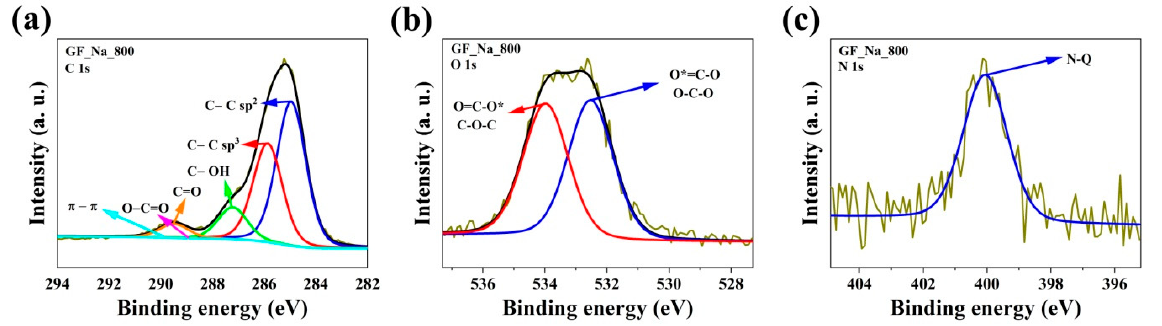
Figure 3. High-resolution X-ray photoelectron spectra for C1s, O1s, and N1s of representative sample: